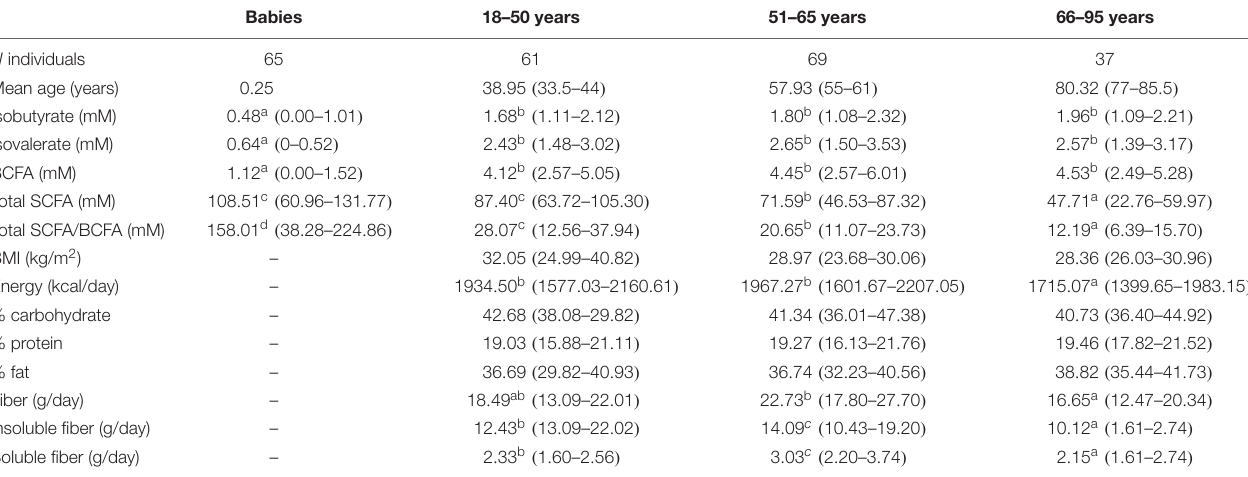
TABLE 1 | Fecal short-chain fatty acid (SCFA), branched short-chain fatty acids (BCFA), and total SCFA/BCFA ratio, as well as general characteristics and daily dietary intakes of the studied population according to age groups.